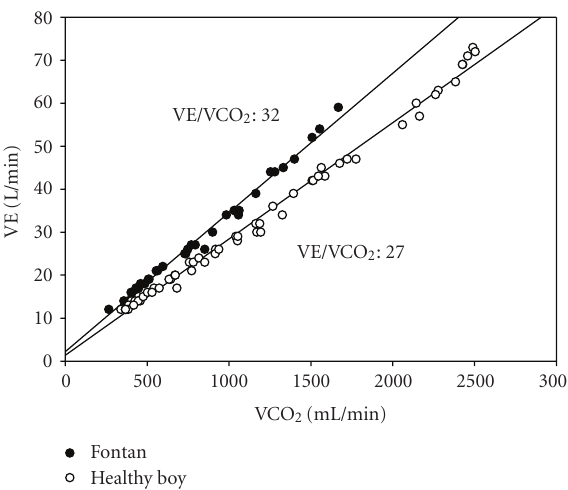
Figure 1: The VE/VCO 2 slope in a 13 year old boy with a Fontan circulation and in a 13-year old healthy boy.